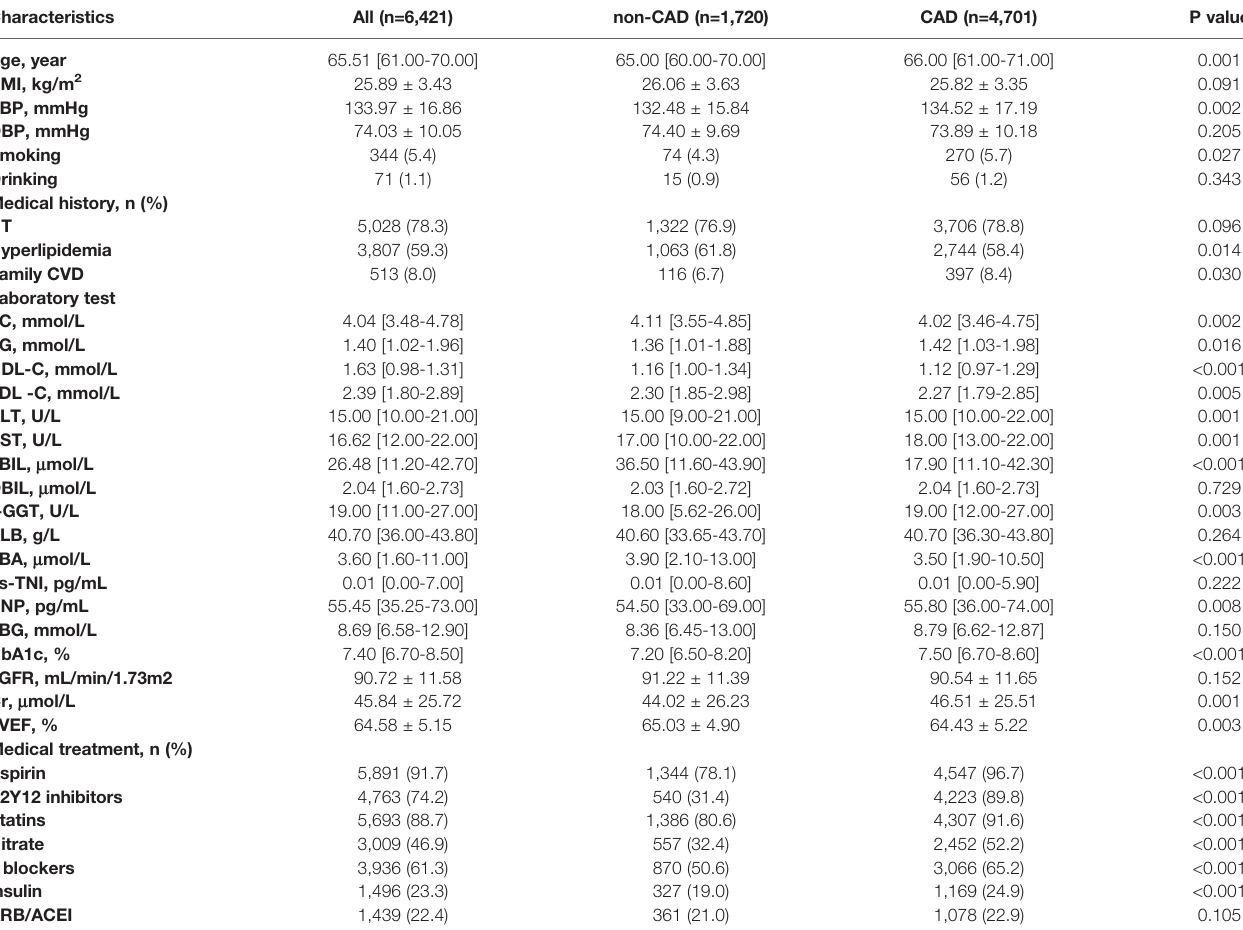
TABLE 2 | Baseline characteristics in T2DM subgroup.